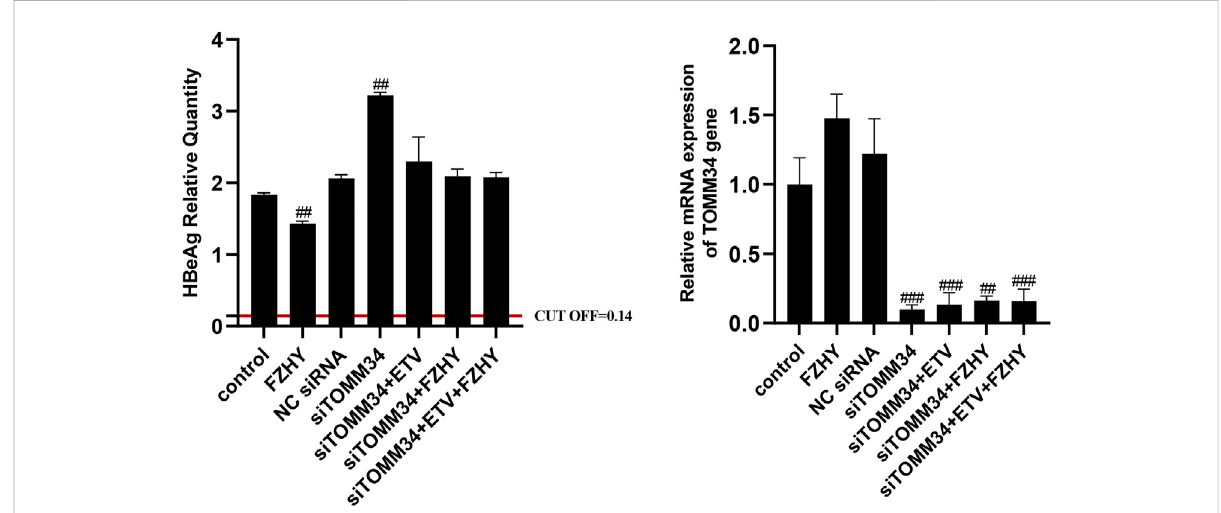
FIGURE 6 EffectofFZHYonHBeAgproductionintheTOMM34gene-knockeddownHepG2.2.15cells.Eachgroupvs.NC(negativecontrol)siRNAgroup, # p < 0.05, ## p < 0.01, ### p <